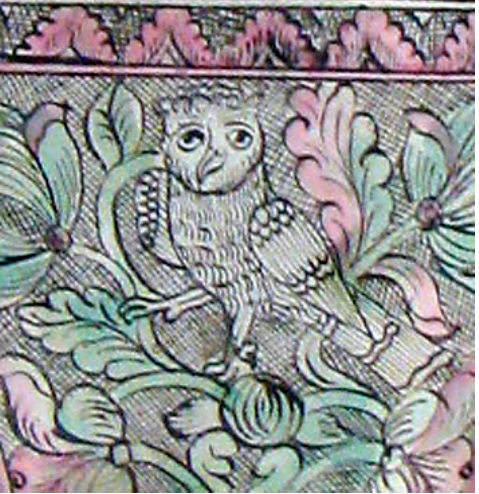
Figure 7. An owl. “Passover Haggadah”, Ihringen, 1732; Jerusalem, The Israel Museum, Ms. 181/48, Fol. 26v. Used by permission.